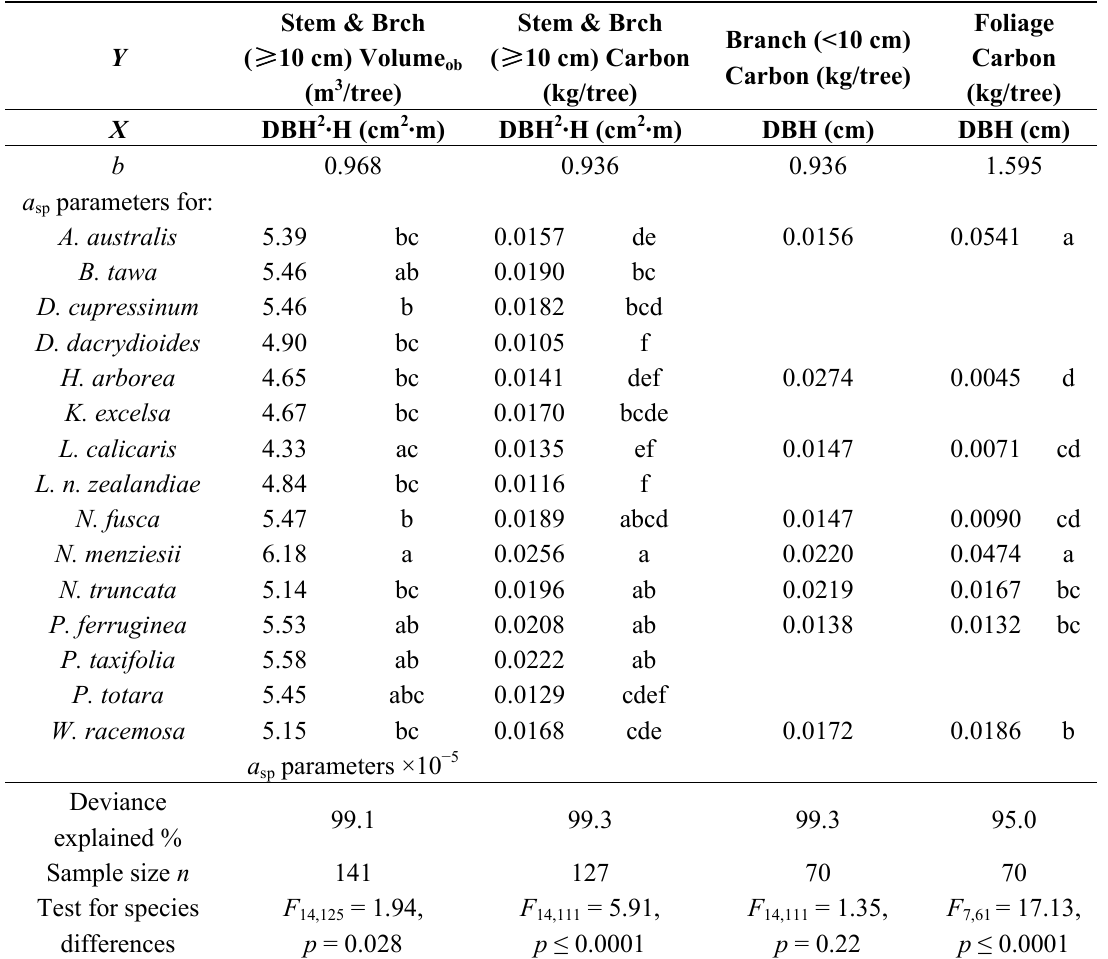
Table 3. Allometric equations for estimating stem and large branch volume and component carbon for natural forest trees with species specific parameters. Values in a column followed by the same letter do not differ significantly (least significant difference test with p =